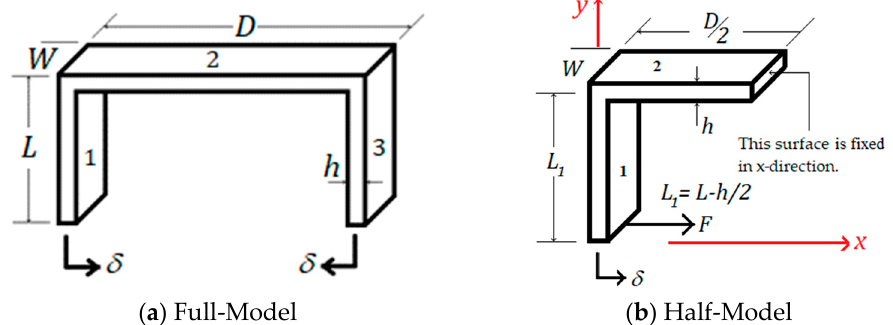
Figure 9. Plastic or aluminum component subject to displacement δ at the free ends.